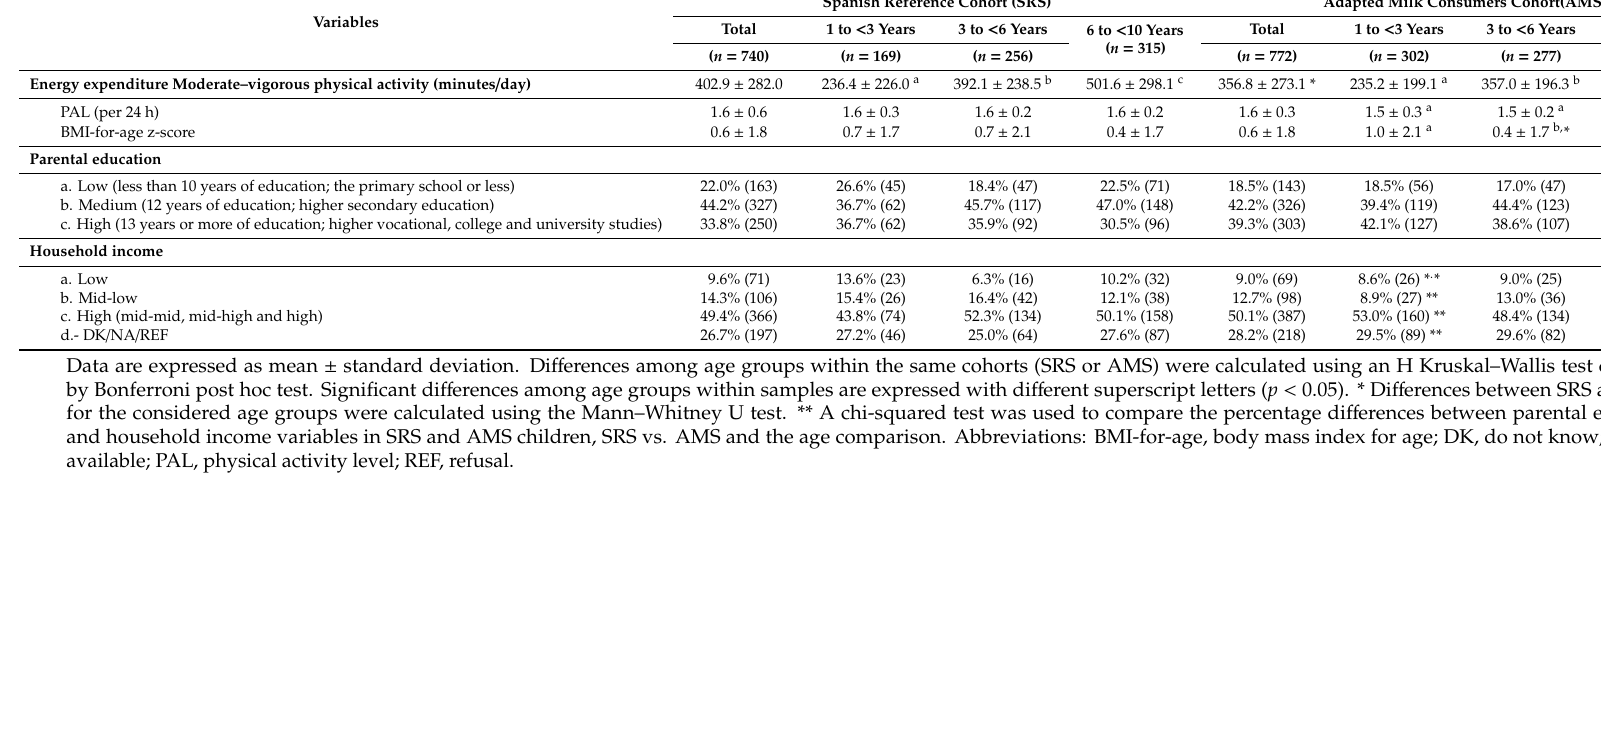
Table 3. Sociodemographic variables in the Nutritional Study in Spanish Pediatric Population (EsNuPI; n = 1512).